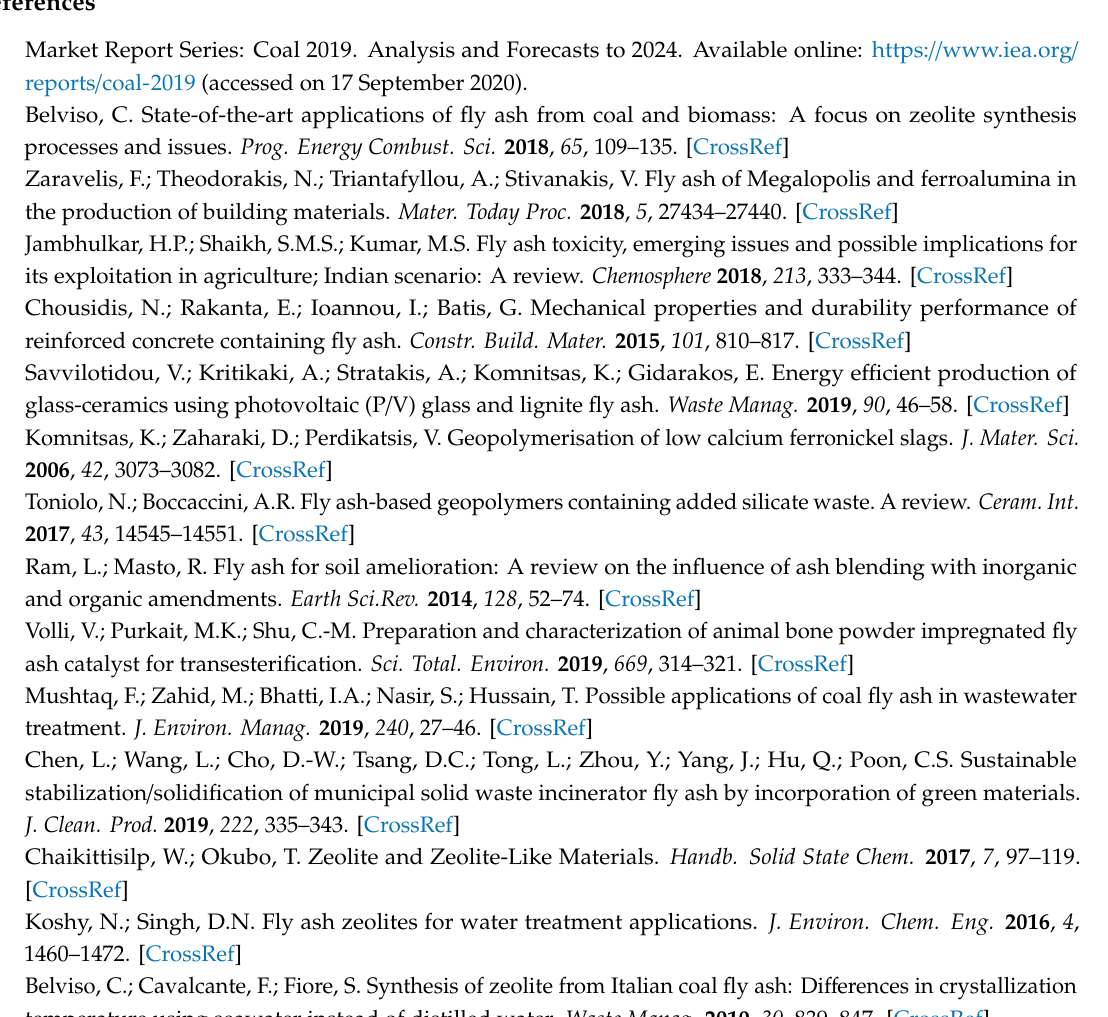
Figure S1: Calculation of saturation indices (SI) at di ff erent pH (2–10) with respect to atacamite (Cu 2 (OH) 3 Cl), CuO, Cu(OH) 2 , and Cu 2 (OH) 3 NO 3 using PHREEQC code v.3.4.0 and minteq.v4 database. Figure S2: XPS core level spectra of Cu2p, Si2p, and a combined Al2p–Cu3p region of ZFA1Na (a) before and (b) after copper removal